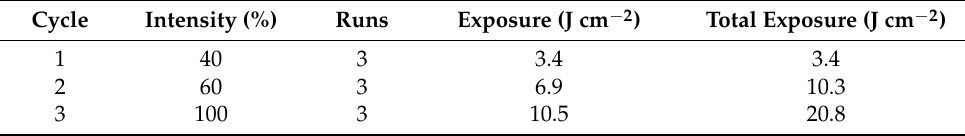
Table 2. Exposure profile applied for specimen production.